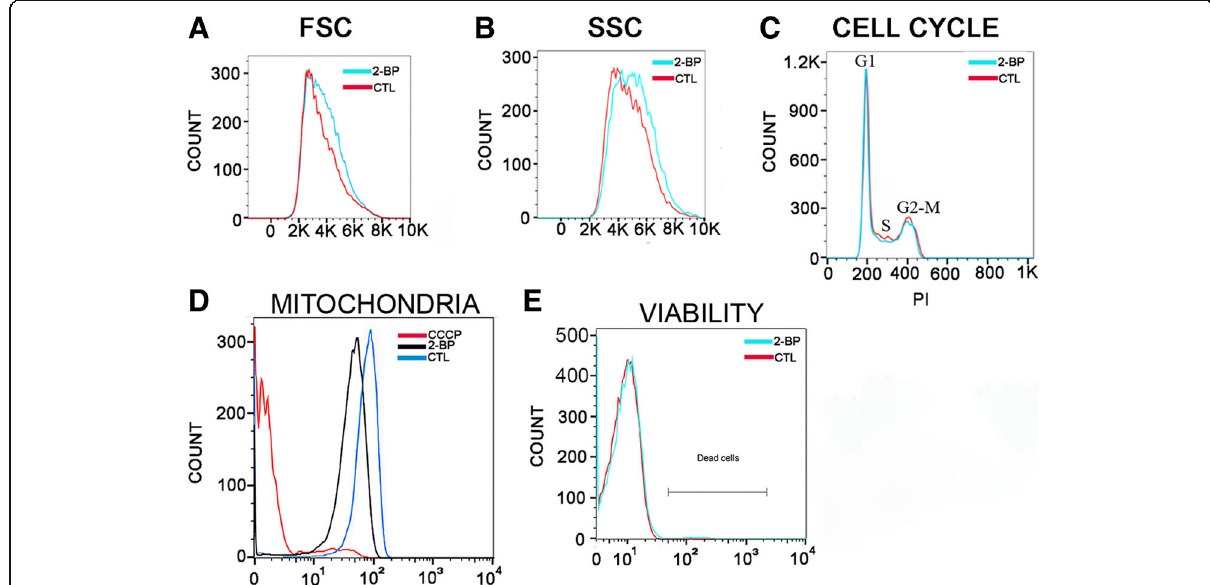
Fig. 4 Effect of incubation with IC50/48 h 2-BP on Trypanosoma cruzi epimastigotes as assessed by flow cytometry. a Forward scatter (FSC) analysis of control (CTL) and treated parasites, showing the larger size of the treated epimastigotes. b Side scatter (SSC) analysis of CTL and 2-BP parasites, showing an increase in granularity. c Cell cycle analysis, showing no difference between CTL and 2-BP treated parasites in the different cell cycle stages. d Mitochondrial potential analysis by rhodamine-123, showing a decrease in the membrane potential for 2-BP-treated epimastigotes; 100 μ M CCCP: positive control. e Cell viability analysis of CTL and 2-BP parasites by propidium iodide, showing a few dead cells in 2-BP-treated